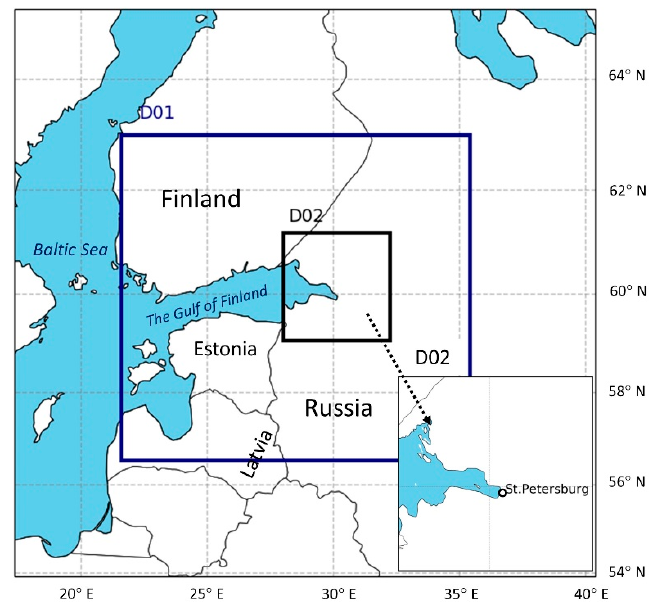
Figure 3. WRF-Chem modelling domains. The outer domain (D01) covers the Leningrad region, the Gulf of Finland, the southern part of Finland, Estonia, and part of Latvia. The inner domain (D02) contains more than half of the Leningrad region territory, with Saint Petersburg in the center. Six model runs were performed. In runs 1ab, we considered biogenic and anthropogenic CO 2 sources and sinks, which vary in time; in runs 2ab and 3ab, only varying and constant in time